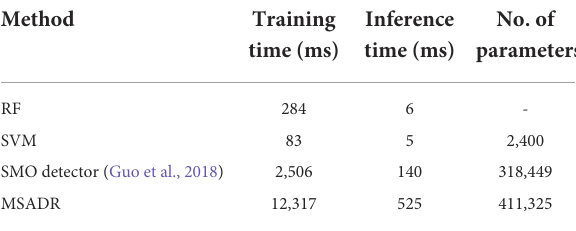
TABLE 3 Computational cost comparison of RF, SVM, SMO, and